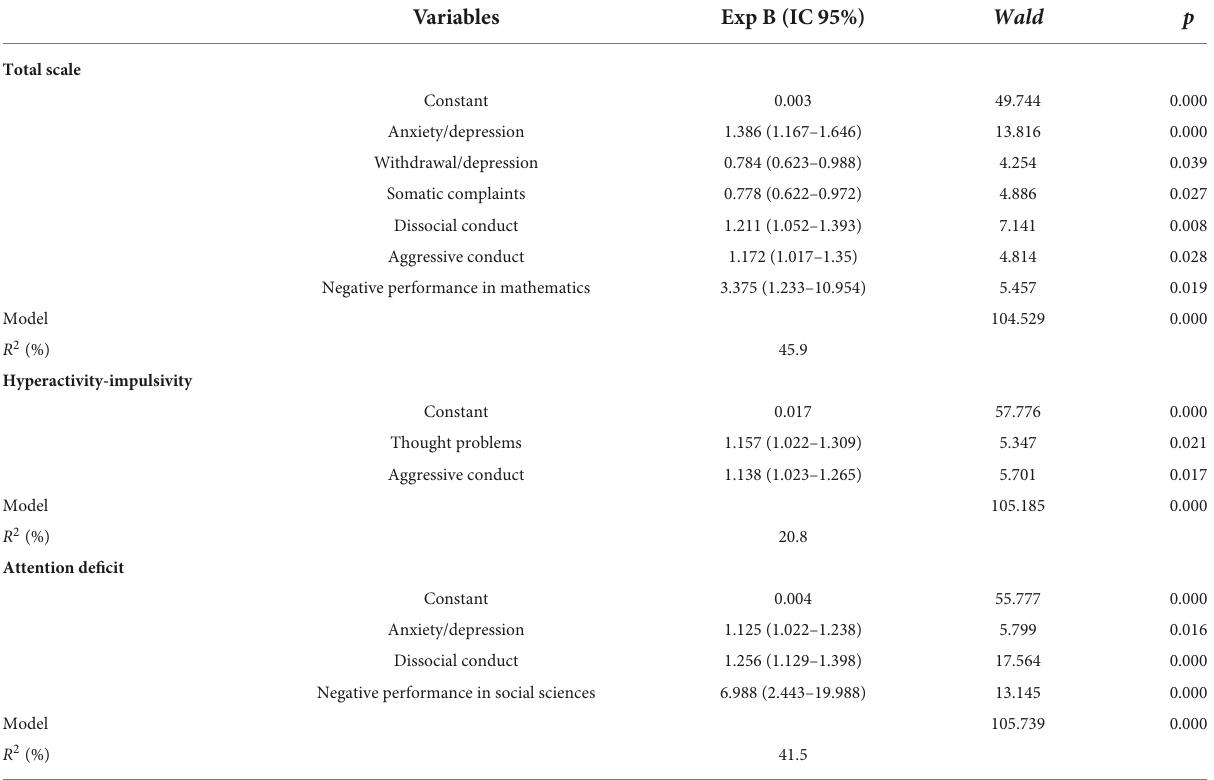
TABLE 7 Attention deficit hyperactivity disorder binary logistic regression analysis adapted with psychopathology and academic performance